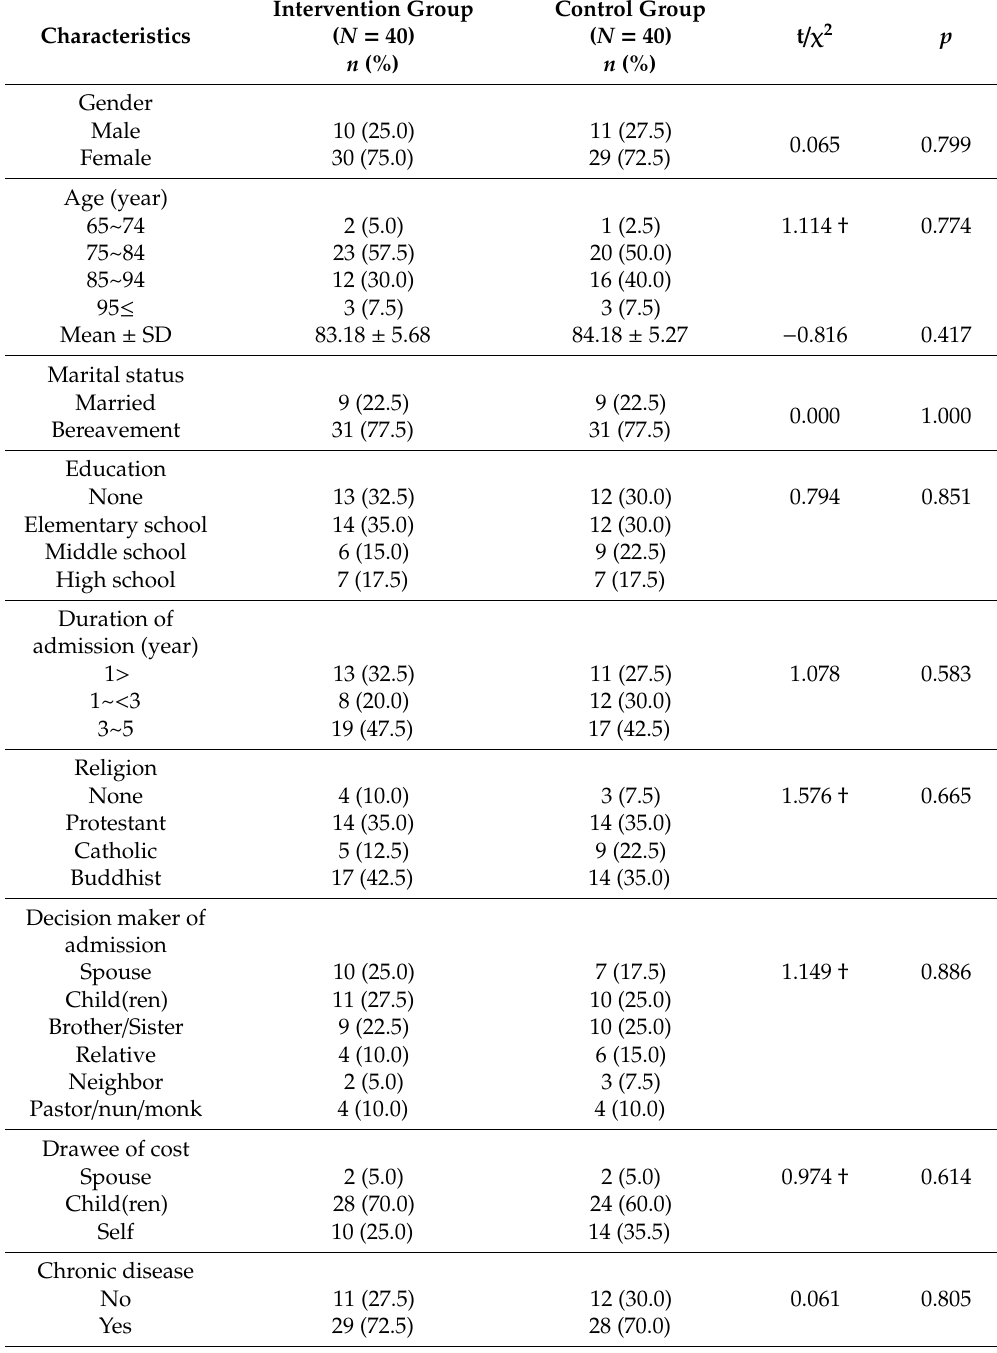
Table 2. General characteristics of study participants and